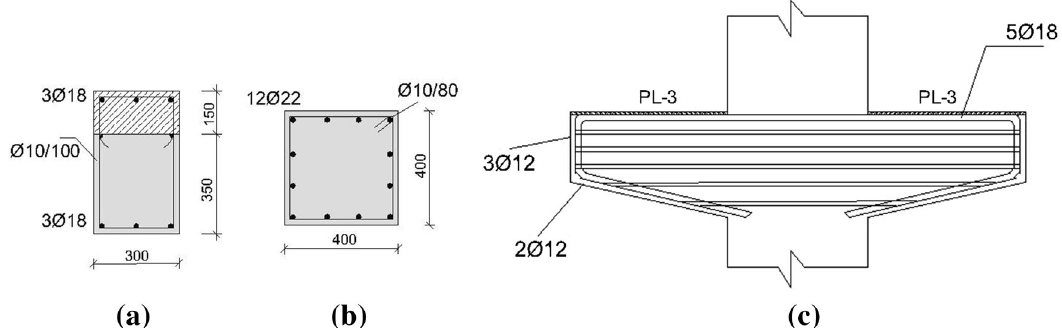
Fig. 8 Geometry and reinforcing details of precast specimens, a beam cross section, b column cross section, and c corbel details.